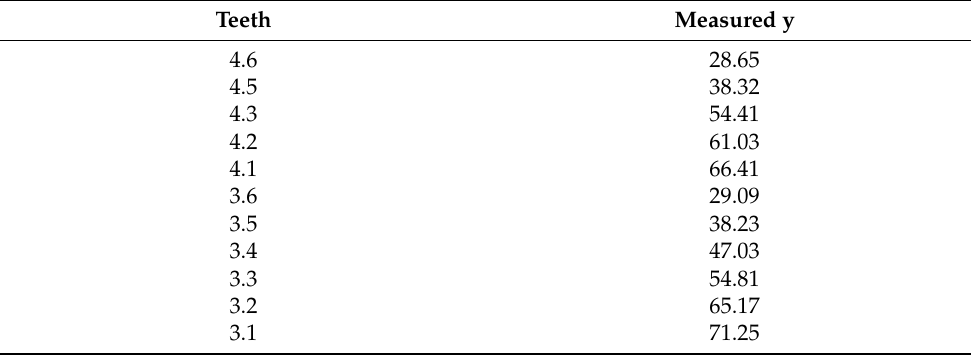
Table 6. Y coordinate values for the lower